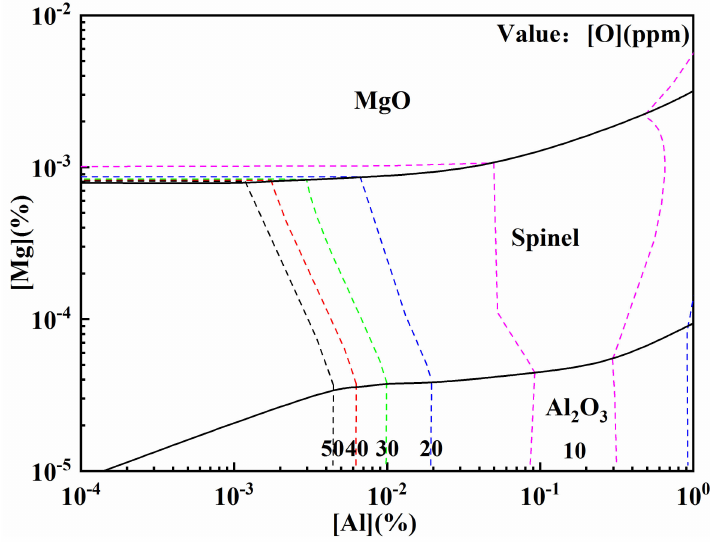
Figure 6. Calculated phase stability diagram of the Mg–Al–O system with iso-oxygen contours in 15-5PH (14.5%Cr-5.2%Ni-3%Cu-0.7%Mn-0.4%Si-0.3%Mo-0.2%Nb-0.05%C-Fe) stainless steel at 1873 K after Al